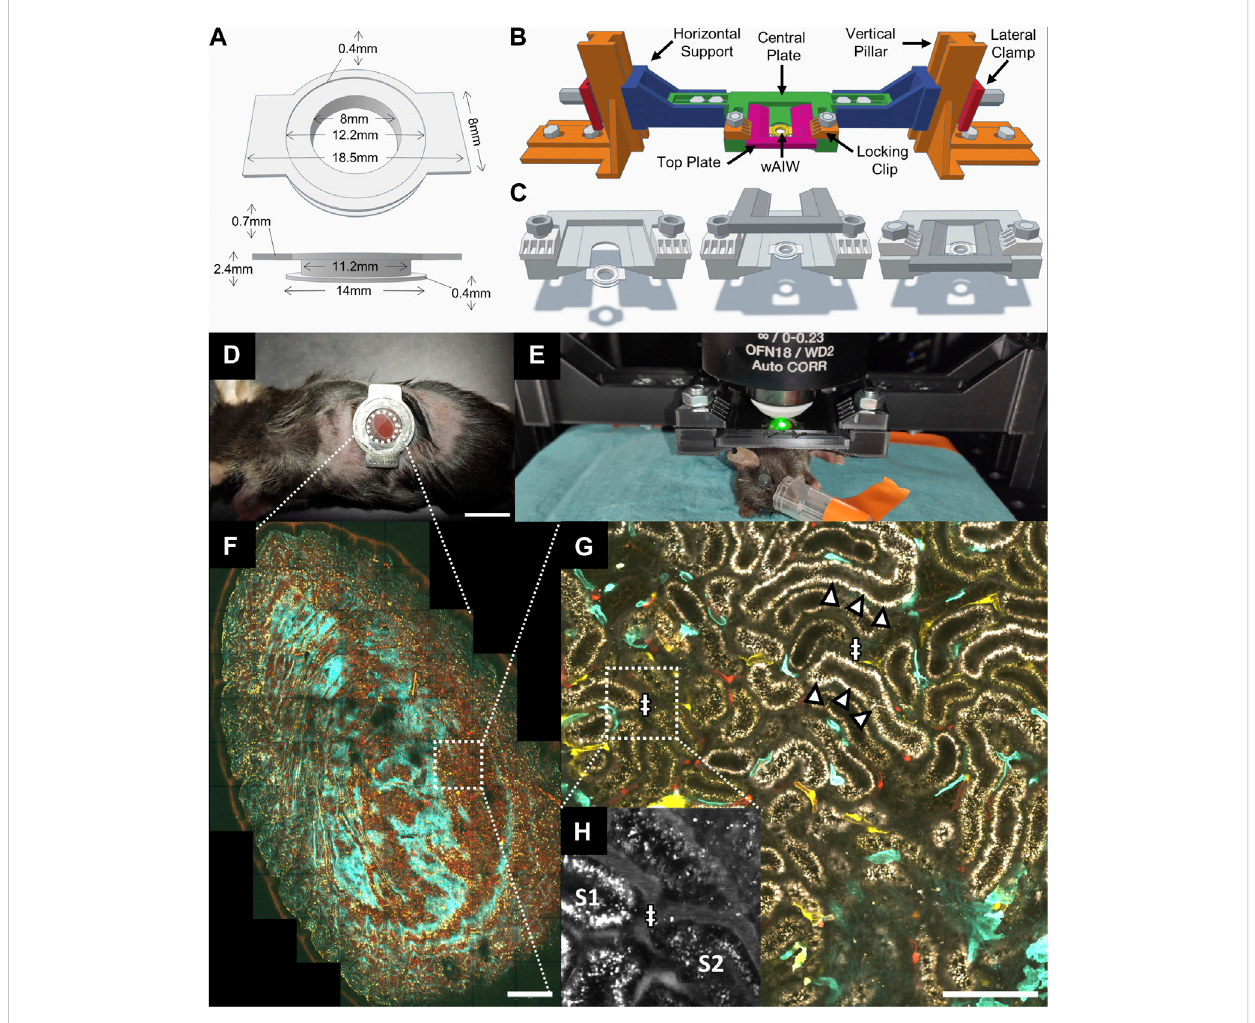
FIGURE 1 Intravital microscopy setup for upright imaging of the kidney across mm and sub-µm scales with a custom 3D printed animal holder. (A) 3D model anddimensionsofawingedabdominalimagingwindow(wAIW)forserialimagingmadefromtitanium. (B) wAIWslottedintoacustom3D-printedanimal holder. The animal holder can be assembled from indicated parts that were printed separately on a consumer-grade 3D printer. (C) Individual steps of wAIWmounting.ThewAIWgetsslottedintothecentralplateoftheanimalholderandislockedintoplacebyatopplate fi xatedthrough2lateralclips and 2 M6 bolts and nuts. (D) Anesthetized mouse after wAIW implantation showing correct orientation of the wings (facing dorsally and ventrally) to preventhindlimbhindrance. Notetheattachedkidney surfaceto thecoverslip. Scalebar=10 mm. (E) Experimental setupfor intravital microscopyofthe kidney or other abdominal organs with an upright 2-photon microscope. The anesthetized mouse is mounted to the animal holder and placed on a heating pad on the microscope stage. (F) Maximum intensity projection of an intravital 2-photon microscopy 3D atlas scan acquired in a Cdh5-Confetti mouse kidney (Table 1) illustrates the potential of intravital microscopy to image mm-scale tissue regions. Scale bar = 500 µm. (G) High-resolution view (4096 × 4096 px, 124 nm/px) of a Cdh5-Confetti mouse provides paired morphological and functional readouts. Endothelial cells expressing